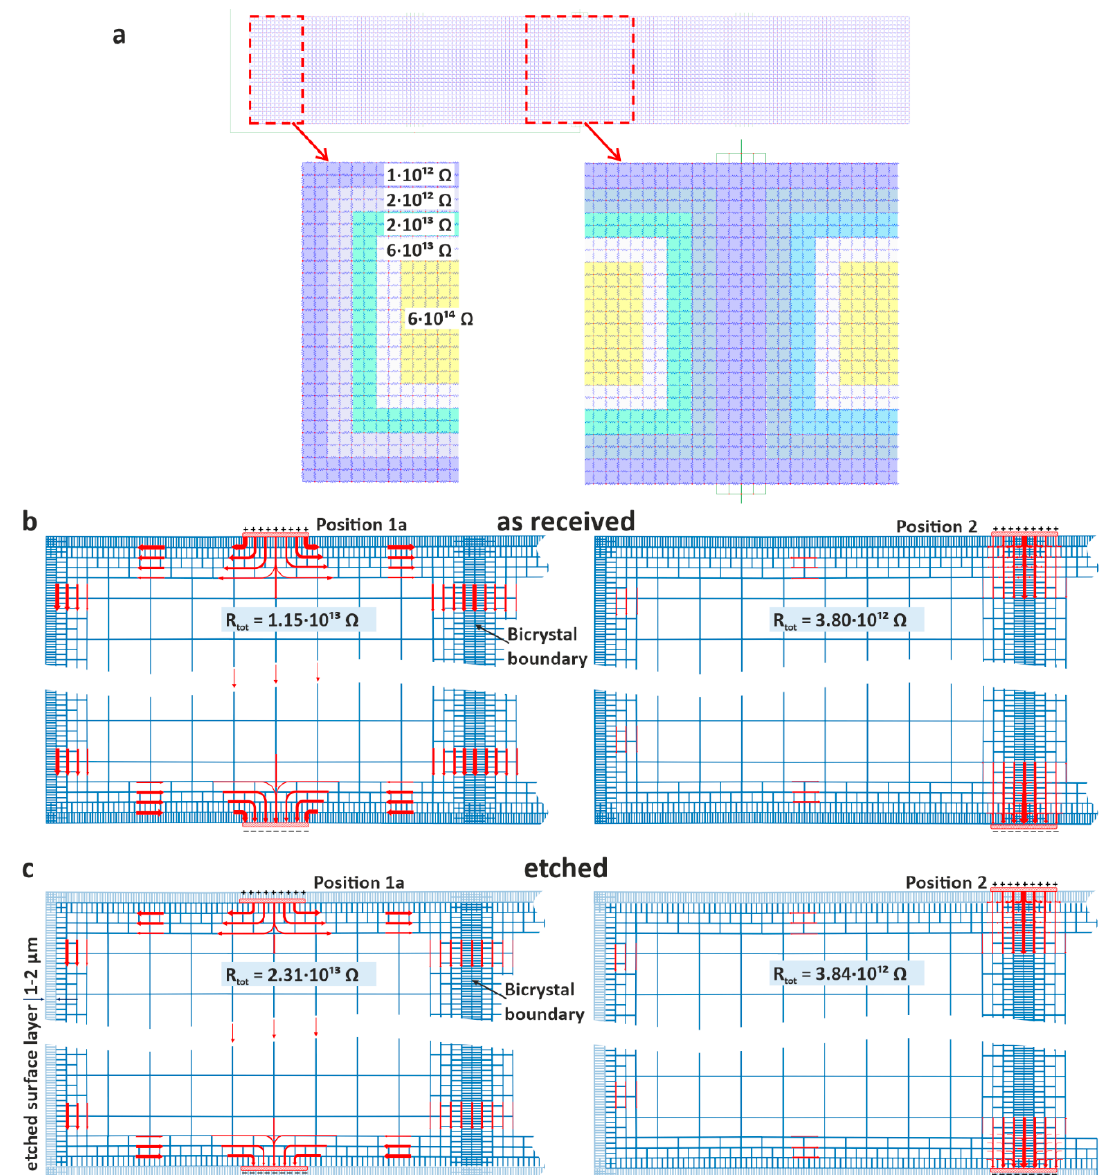
Figure 8. Simulation of the electronic transport using a resistor grid representing a hierarchical tree of filaments. ( a ) Outline of the simulation cell, ( b ) simulation result for the as received and ( c ) the etched bicrystal. The thickness of the red arrows represents the simulated current values.